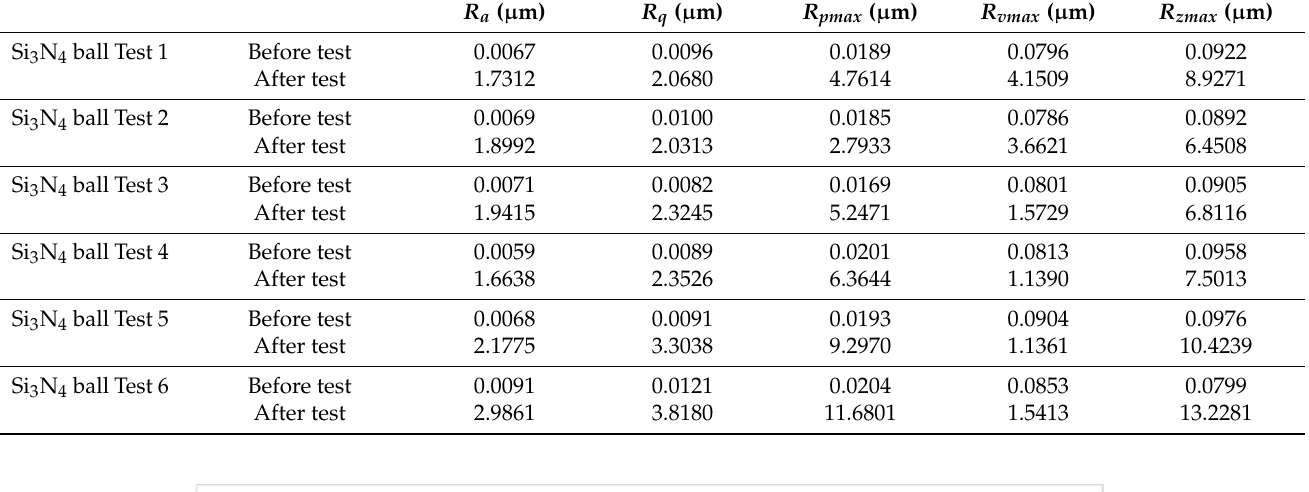
Table 7. Surface roughness values of balls before and after testing.